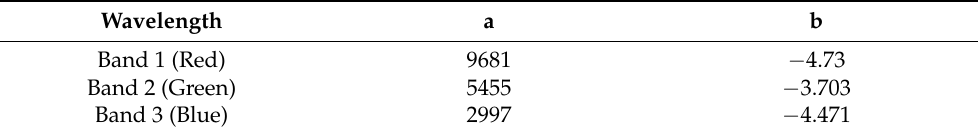
Table 1. Radiance calibration coefficients of